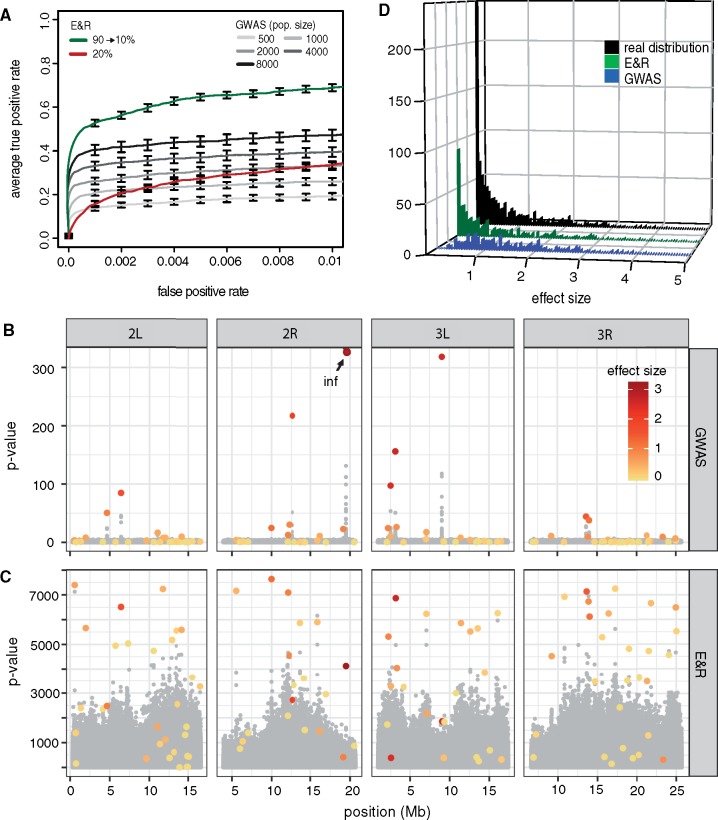
Performance of E&R and GWAS. (A) Performance of GWAS with different population sizes and E&R studies using a powerful (green; 90 → 10%) and a suboptimal selection regime (red; constant 20%). The E&R study with an optimized selection regime has a higher power to identify QTNs than the evaluated GWAS. (B) Manhattan plot for a GWAS (N = 8,000). The effect sizes of QTNs are shown in a color gradient, where large effect loci are red. (C) Manhattan plot for an E&R study (N = 1,000, powerful selection regime). (D) Histogram of the effect sizes recovered with GWAS and E&R. The 2,000 most significant SNPs were used for each approach. The GWAS recovered mostly loci of large effect size whereas the E&R also recovered many loci of small effect. A summary over ten experiments is shown.